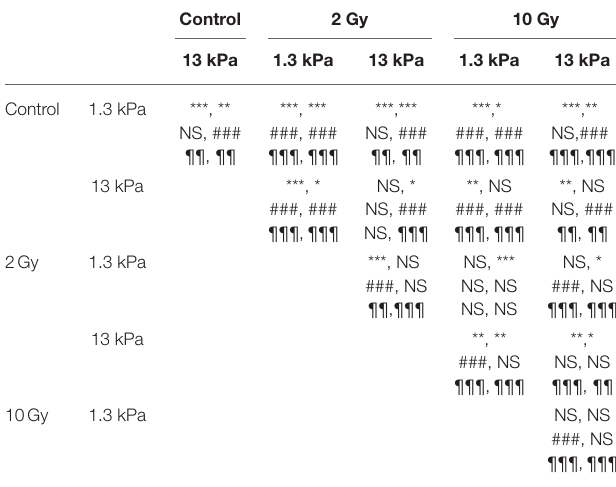
TABLE 1 | Statistical analysis for trajectories